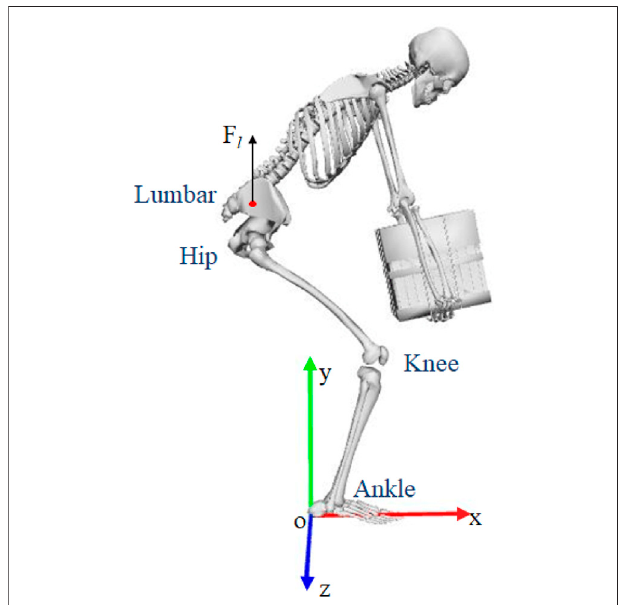
FIGURE 1 | Schematic diagram of human lifting